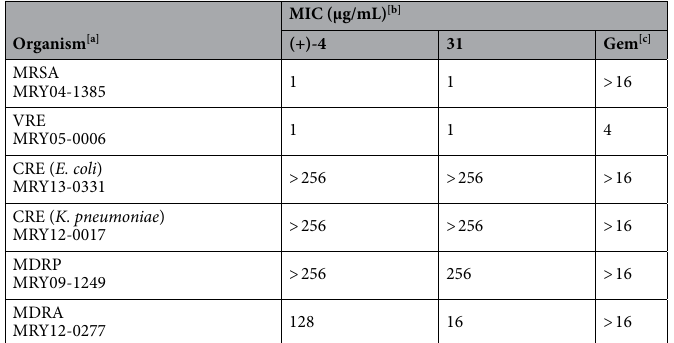
Table 2. Antimicrobial evaluation of synthesized (+)- 4 and 31 against antimicrobial-resistant (AMR) bacterial isolates. Determined by CLSI broth microdilution methods. [a] Measured concentration (0.125–256 µg/mL). MRSA : methicillin-resistant Staphylococcus aureus ; VRE: vancomycin-resistant Enterococcus faecium ; CRE: carbapenem-resistant Enterobacterales ( Escherichia coli or Klebsiella pneumoniae ) ; MDRP: multidrug-resistant Pseudomonas aeruginosa; MDRA: multidrug-resistant Acinetobacter baumannii. [b] MIC: Minimum inhibitory concentration. [c] Gem: gentamicin. Measured concentration (0.125–16 µg/mL).